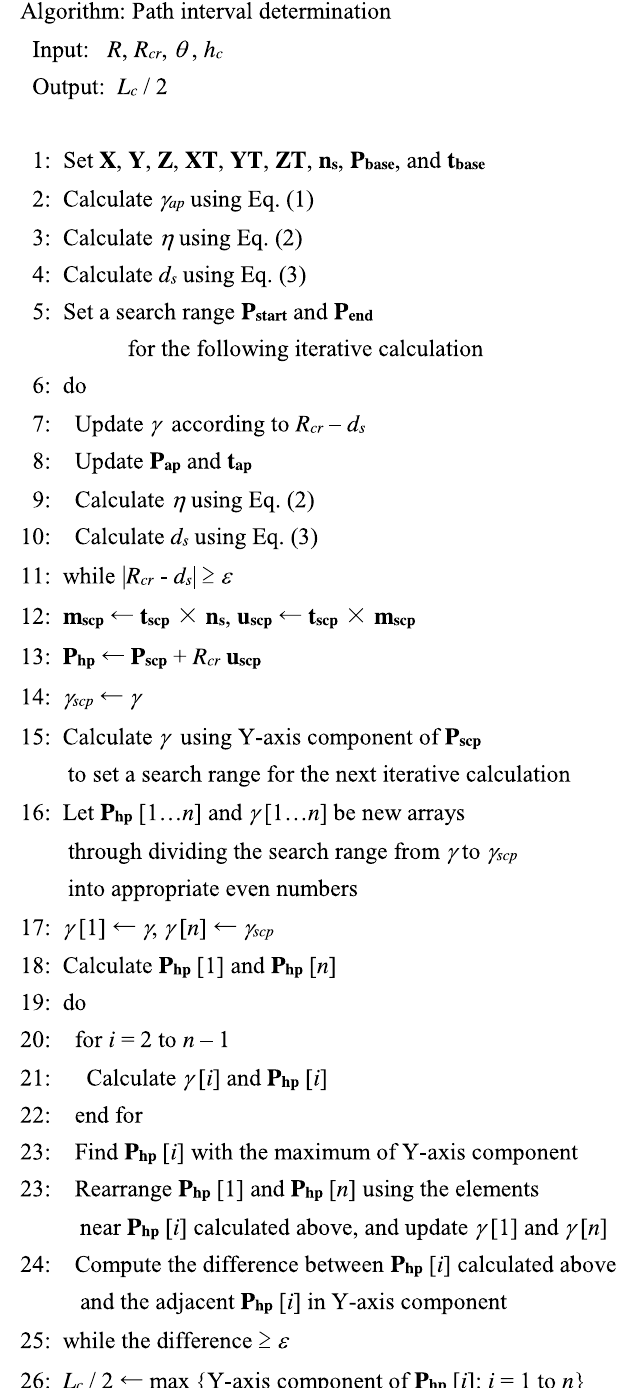
Fig. 7. Computational algorithm for determining L c /2 [26].